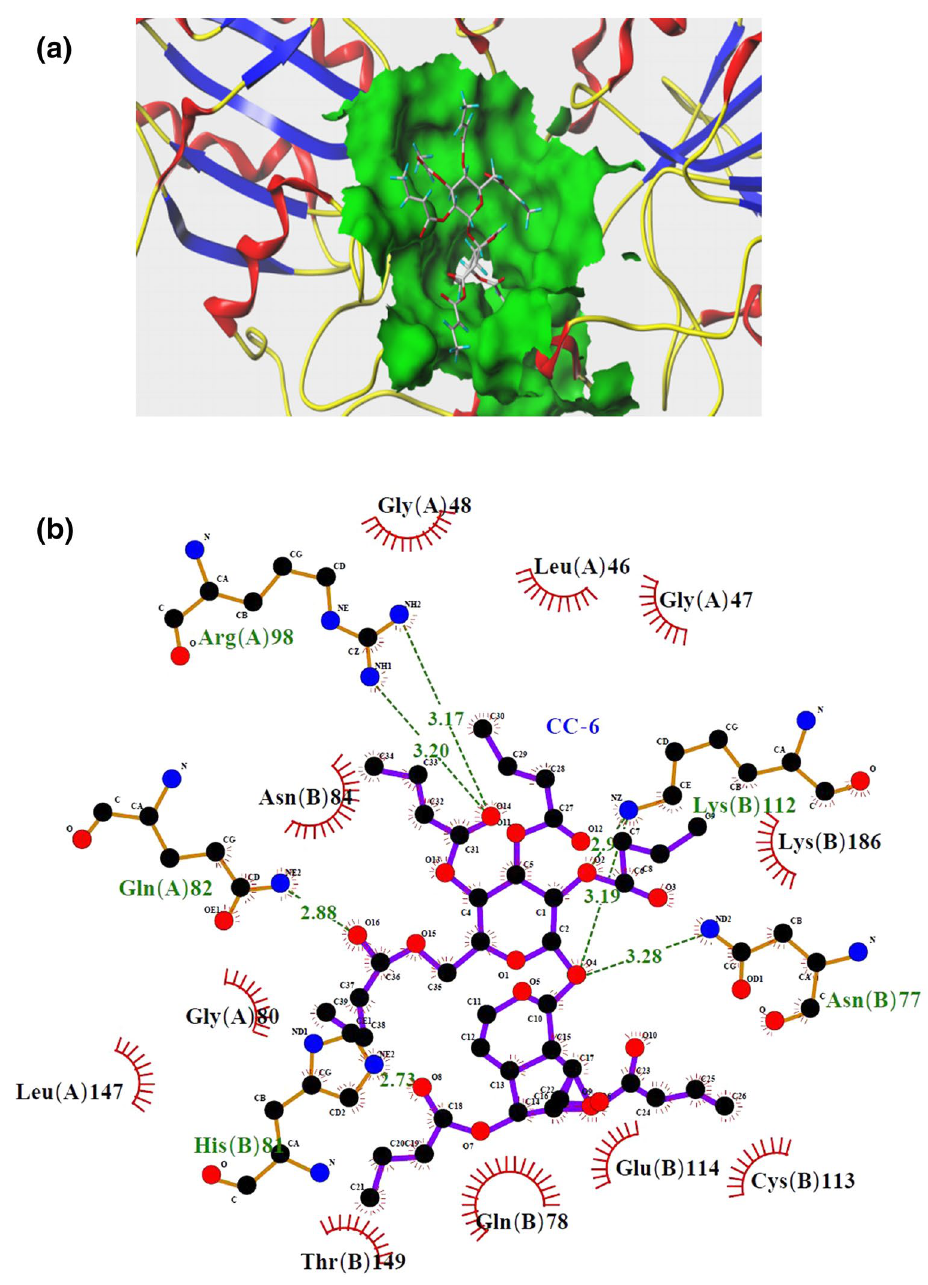
Figure 2. Docking diagram of CC-6 and GSH-Px molecule. ( a ) Docking result of CC-6 with GSH-Px; ( b ) Interaction of CC-6 with